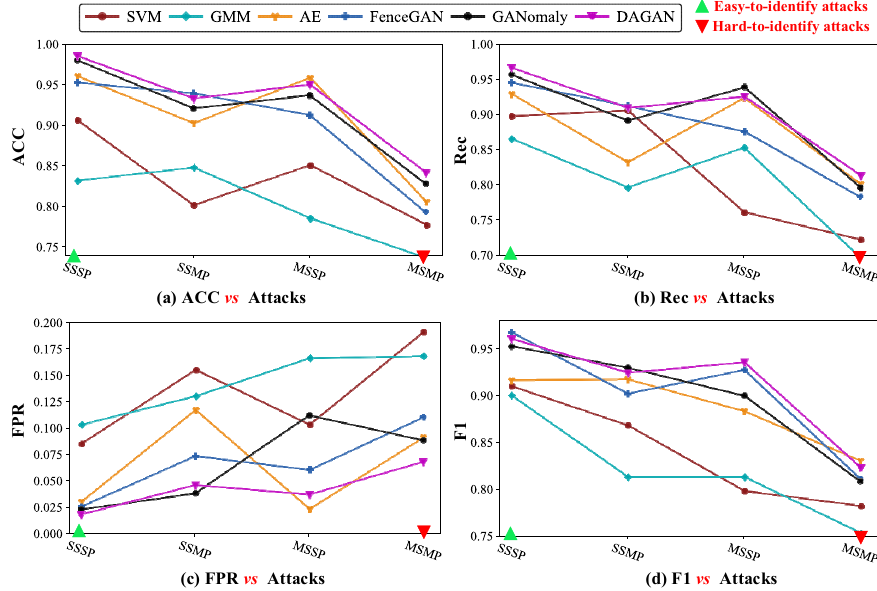
Figure 10. Anomaly detection performance analysis of multiple models on SWaT dataset.